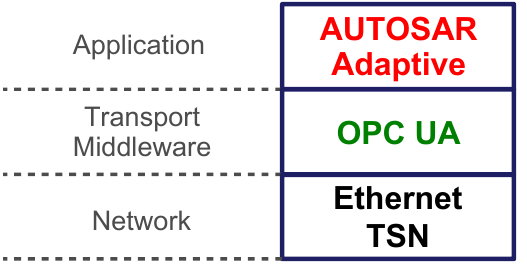
Figure 1. Integration stack of AUTOSAR Adaptive, Open Platform Communications Unified Archi- tecture (OPC UA), and Time-Sensitive Networking